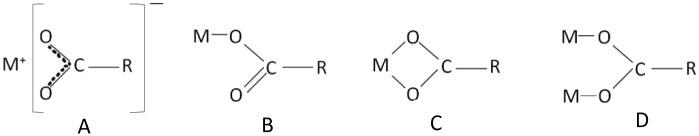
Modes of metal binding by carboxylate ligands: A—ionic or uncoordinated forms, B—unidentate complexes, C—bidentate chelates, D—bidentate bridging coordination.